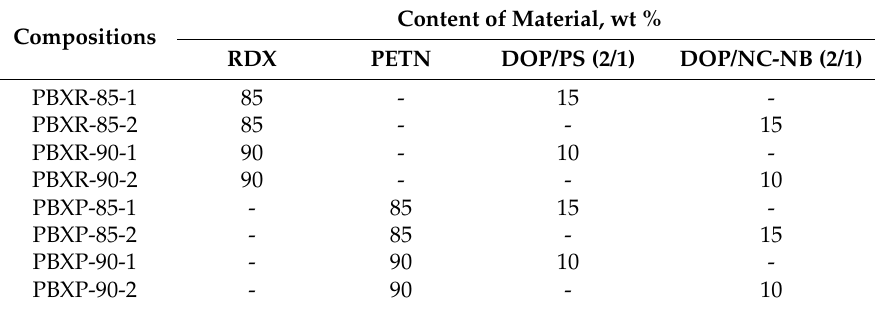
Table 1. Compositions of PBX based on RDX and